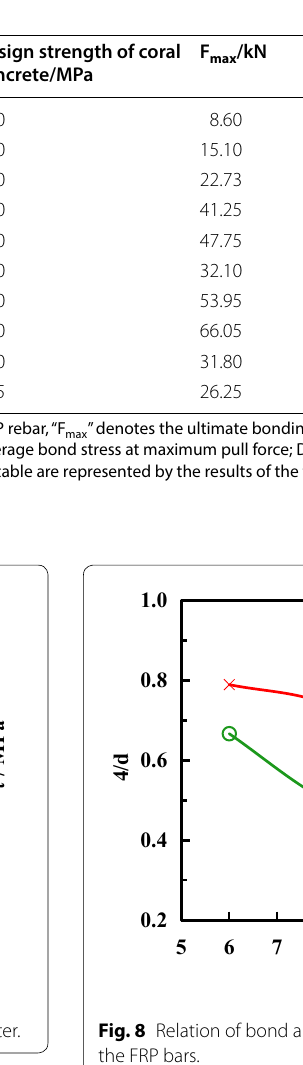
Table 6 Partial test results.